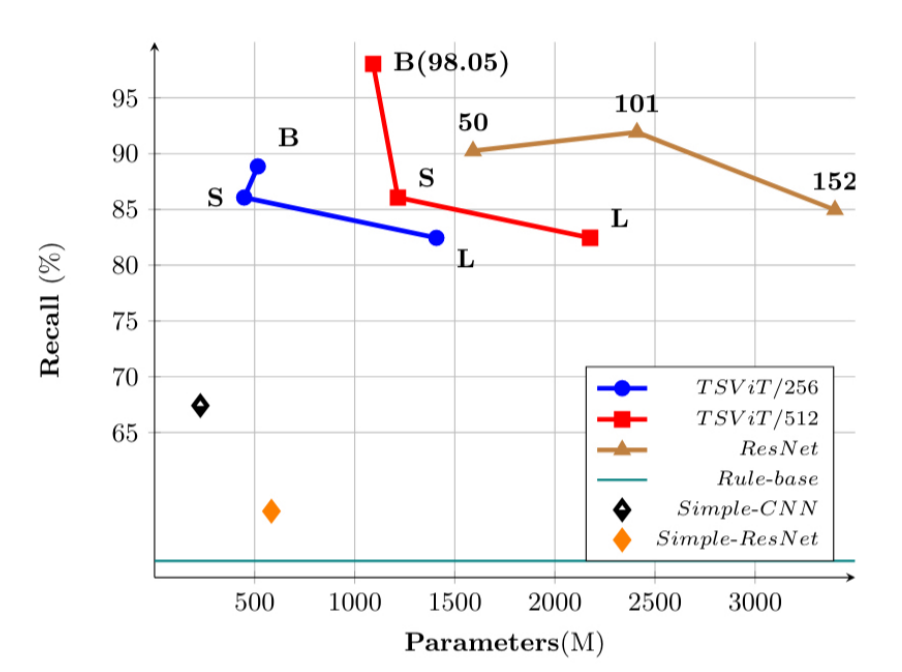
Figure 7. Performance of each network according to model